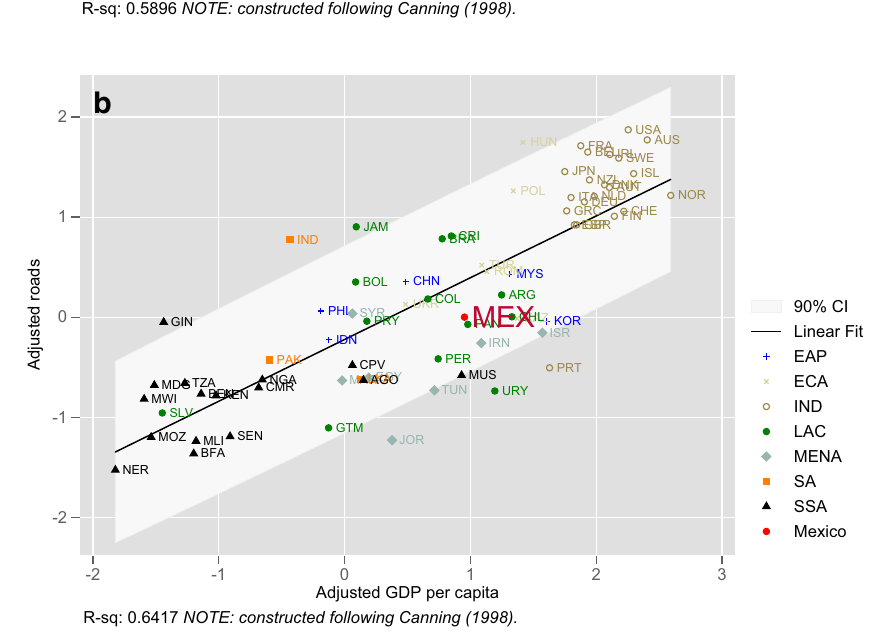
Fig. 6 Adjustments for Transport